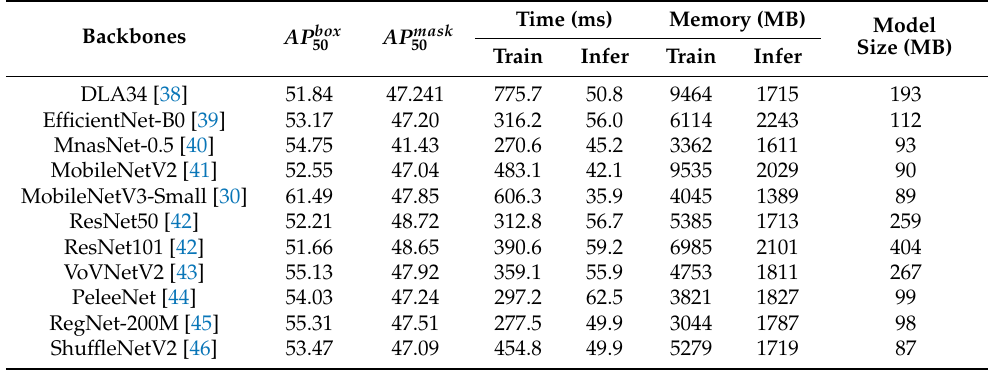
Table 1. Comparison of different backbones.